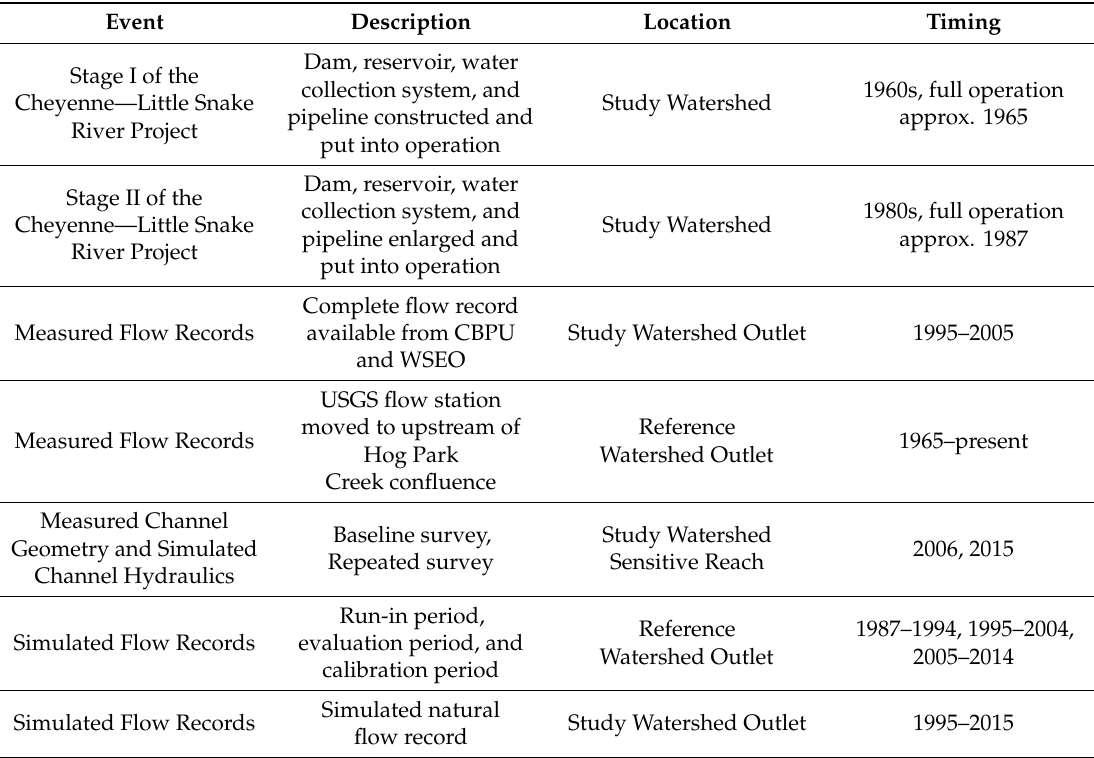
Table A1. Timeline of hydrologic modification at the study watershed.